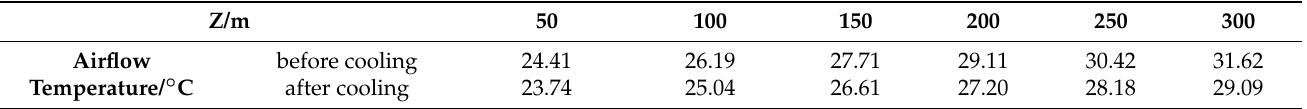
Figure 7. Airflow temperature distribution in different sections of the working face after cooling. Table 1. Airflow temperature along the working face.